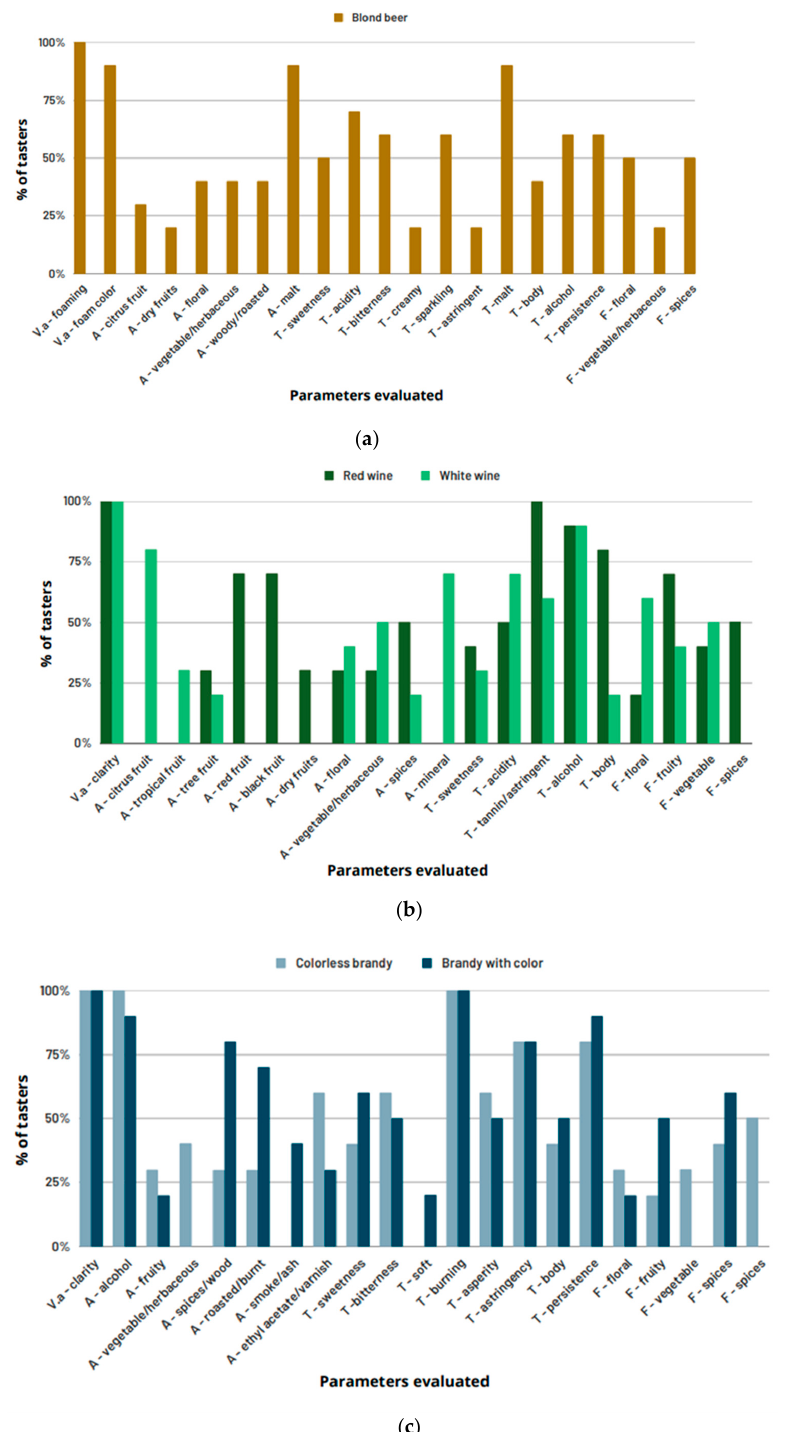
Figure 1. Percentage (%) of P1 tasters by parameters evaluated for beer ( a ), wines ( b ), and brandies ( c ) (Va—visual aspect; A—aroma; T—taste/texture; F—flavor).